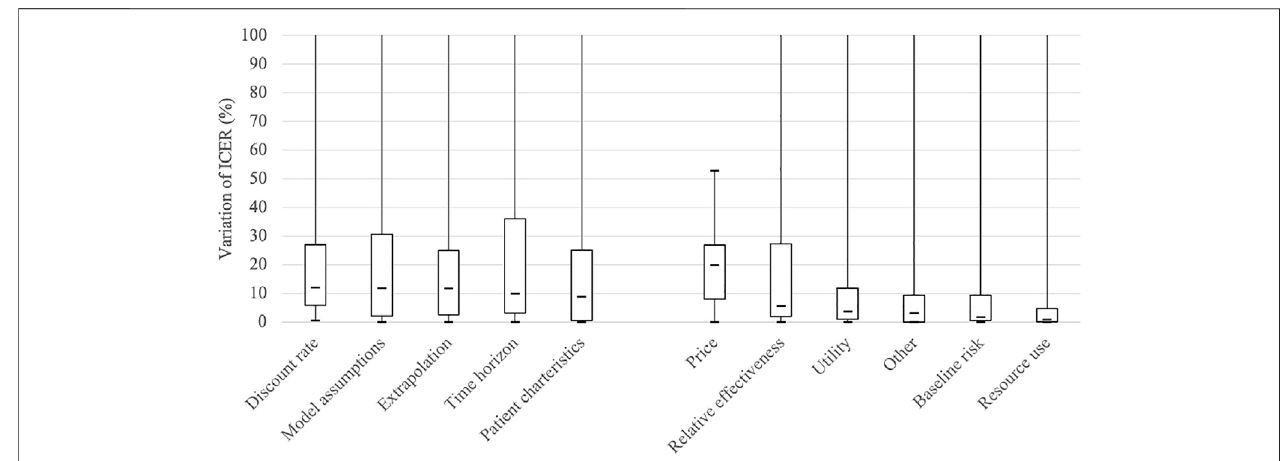
FIGURE 1 | Boxplot comparing the variance of ICER (Incremental cost effectiveness ratio) for each scenario with reference to that of the base case. The “ Other ” implies parameters relevant with speci fi c treatment, such as the incidence of the adverse event, or hospitalization rate.